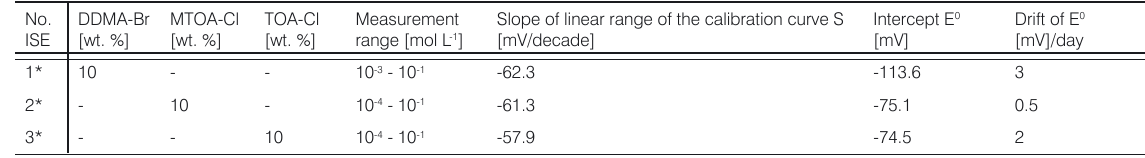
Table 1. Calibration curves of naproxen electrodes containing various quaternary ammonium salts.